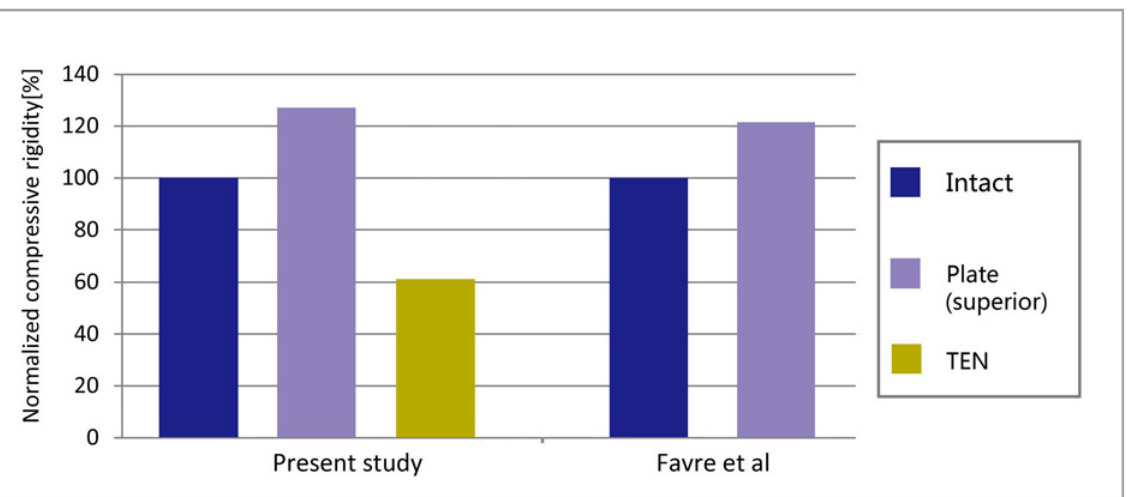
Fig 4. Construct rigidity in the intact clavicle and plate fixation (superior fracture fixation) for axial compression compared with the published experimental data [11]. The values obtained for the intact clavicle were set to 100% and served as a reference.The normalized compressive rigidity was 127.3%, 60.9% for the reconstruction plate model and TEN model, respectively.